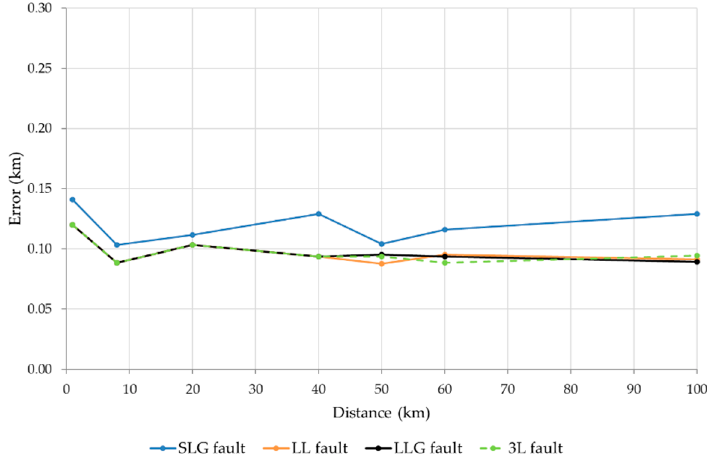
Figure 11. Distance errors for different faults (SLG, LL, LLG and 3L) with a very low inception angle (0 ° ), a soil resistivity of 200 Ω ∙ m and R f = 0 Ω .